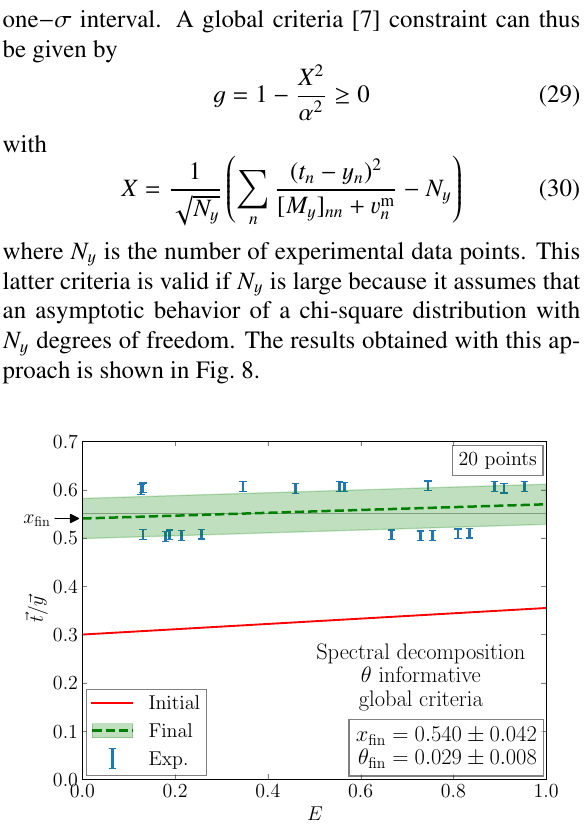
Figure 8. Uncertainty propagation in the spectral method with the global criteria constraint.